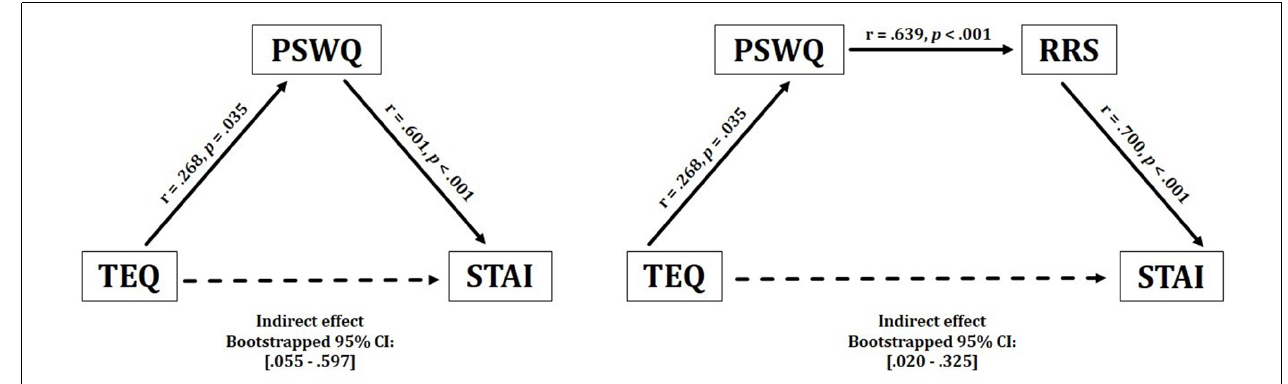
FIGURE 2 | Behavioral results. Empathy demonstrated a significant positive indirect relationship with anxiety, through inconsistent mediation of worry. These effects were observed bidirectionally. Empathy also revealed a positive indirect relationship with anxiety through worry and rumination. TEQ, Toronto Empathy Questionnaire; PSWQ, Penn State Worry Questionnaire; RRS, Ruminative Responses Scale; STAI, State Trait Anxiety Inventory.